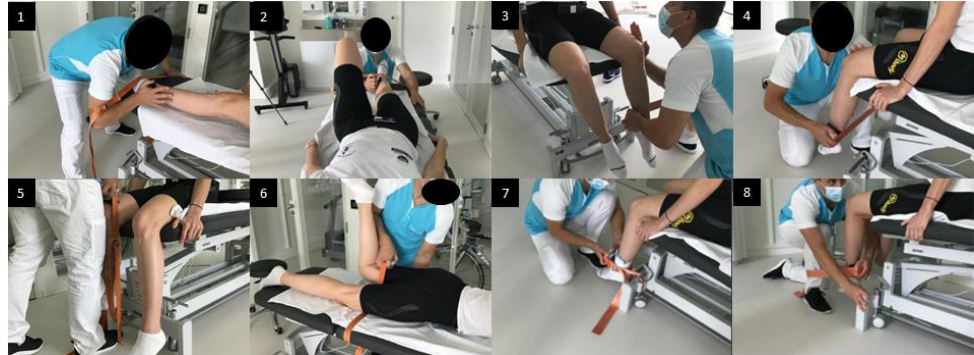
Figure 1. Hip-related muscle groups strength testing positions. (1) Hip abductors, (2) Hip adductors, (3) Hip external rotators, (4) Hip internal rotators, (5) Hip flexors, (6) Hip extensors, (7) Quadriceps, (8) Hamstrings. Further explanations can be found in Supplementary Materials.